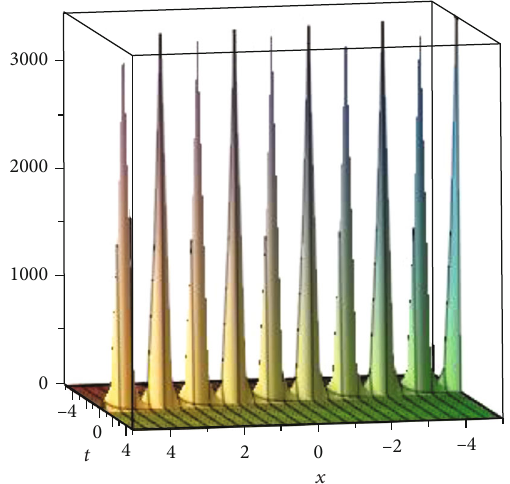
Figure 5: Perspective view of 3D graph of W values ω = 5 , z 0 = 1/3 , μ = 1 , k = 1 , s = 1 , and e = 1 represents exact solutions.